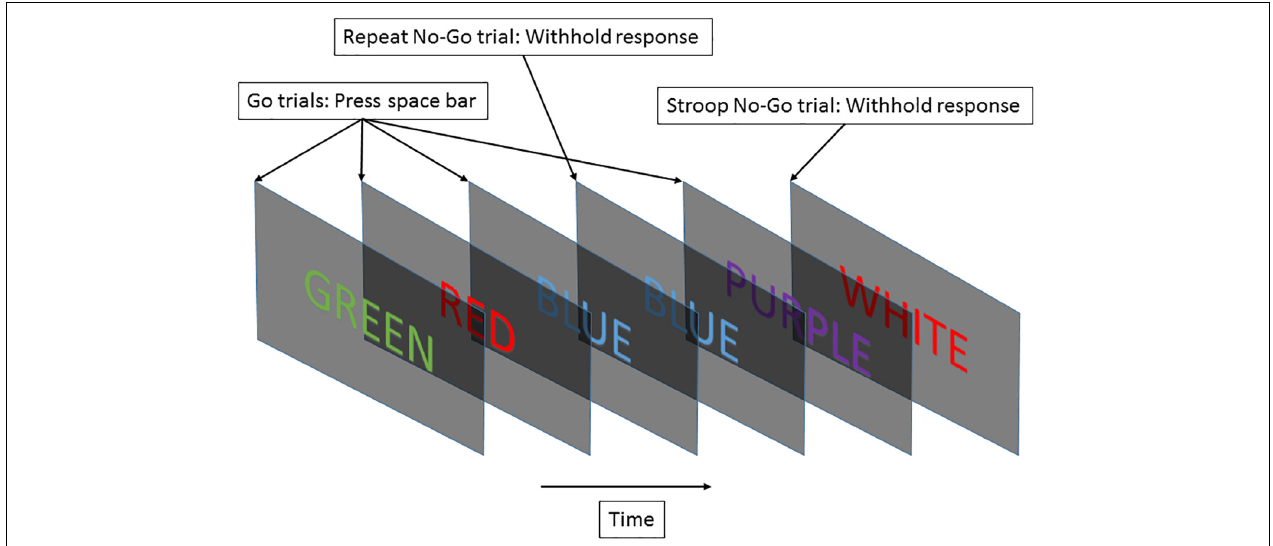
FIGURE 2 | The EAT required subjects to respond to a stream of color names by pressing a key, and to withhold their response based on “No-Go” trial rules.